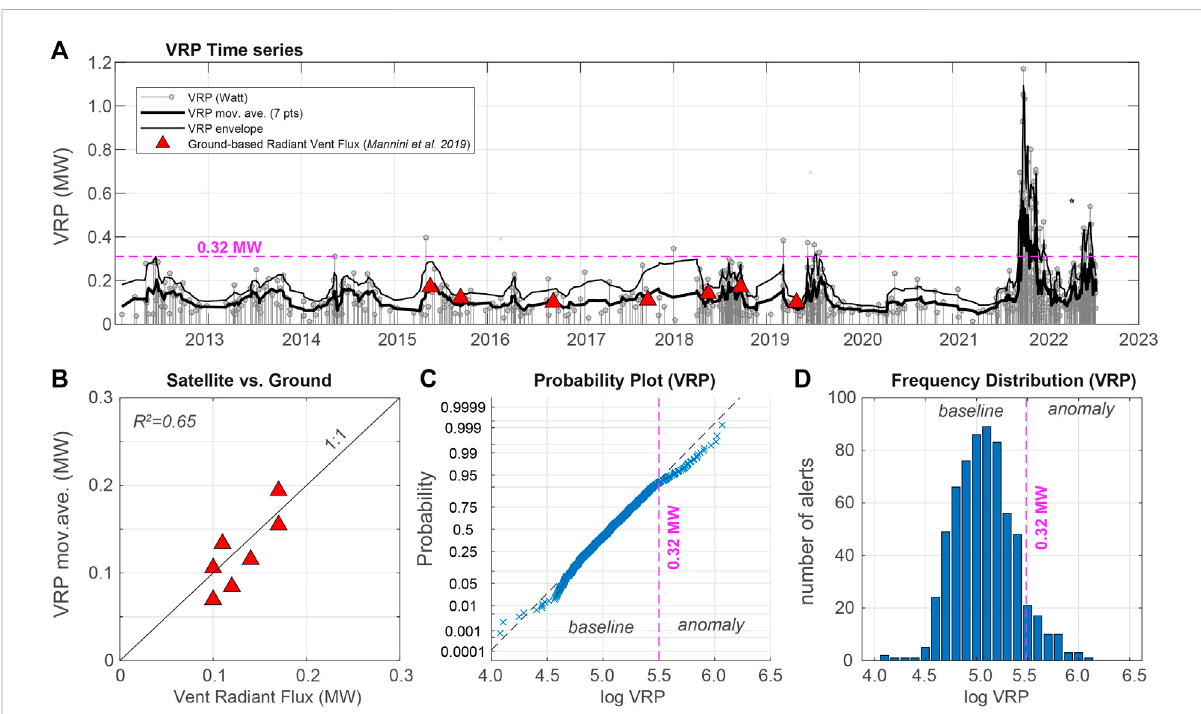
FIGURE 2 (A) Timeseries of Volcanic Radiative Power (VRP) recordedover La Fossa volcano by VIIRS imaging bands (375 m resolution) between2012 and 2022.GraystemscorrespondtosingleVRPdetectionfromVIIRSdata.Thethickblackcurverepresentsthemovingaverage(7points)oftheVRP.The thinblack curverepresents theenvelope of theVRP calculated using Hilbert fi lter. Red triangles correspond to theradiantvent fl ux measured during fi eld campaigns by Mannini et al., 2019. (B) The relationship between satellite-derived VRP and fi eld-derived vent radiant fl ux indicates an excellent correlation ( R 2 = 0.65). (C) Probability plot and (D) frequency distribution of the VRP dataset (log-transformed) outline the presence of two thermal regimes corresponding to the baseline activity (VRP < 0.32 MW) and anomaly ( > 0.32 MW), respectively. The automatic detection of VRP > 0.32 MW occurred at a rate (on a daily scale) of about two orders of magnitude higher since September